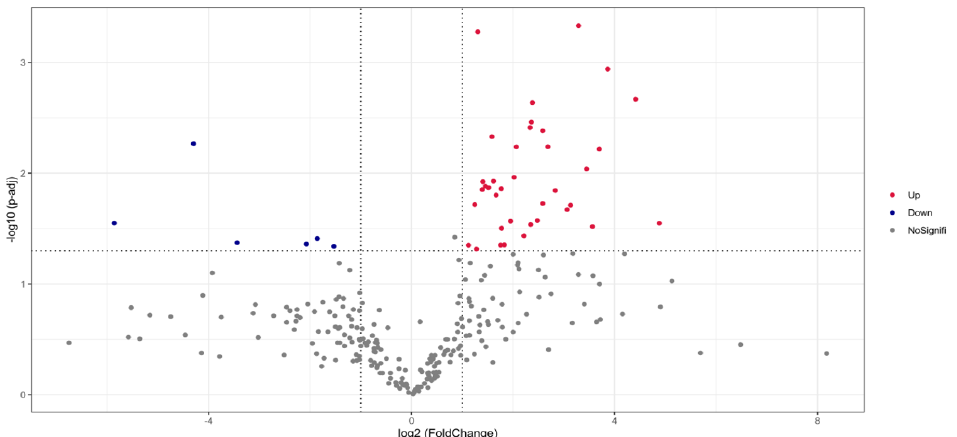
Figure 4. Volcano map of the species diversity of the microbes in GUMT319-treated and untreated grape plant rhizosphere. Result showed that there are 37 upregulated microbes and 6 downregulated microbes that appeared in GUMT319-treated soil compared to the untreated soil. Species with differences in richness were selected by log2 fold change > 1 and q value < 0.005. NoSignifi represents microbes with no significant difference in species richness.